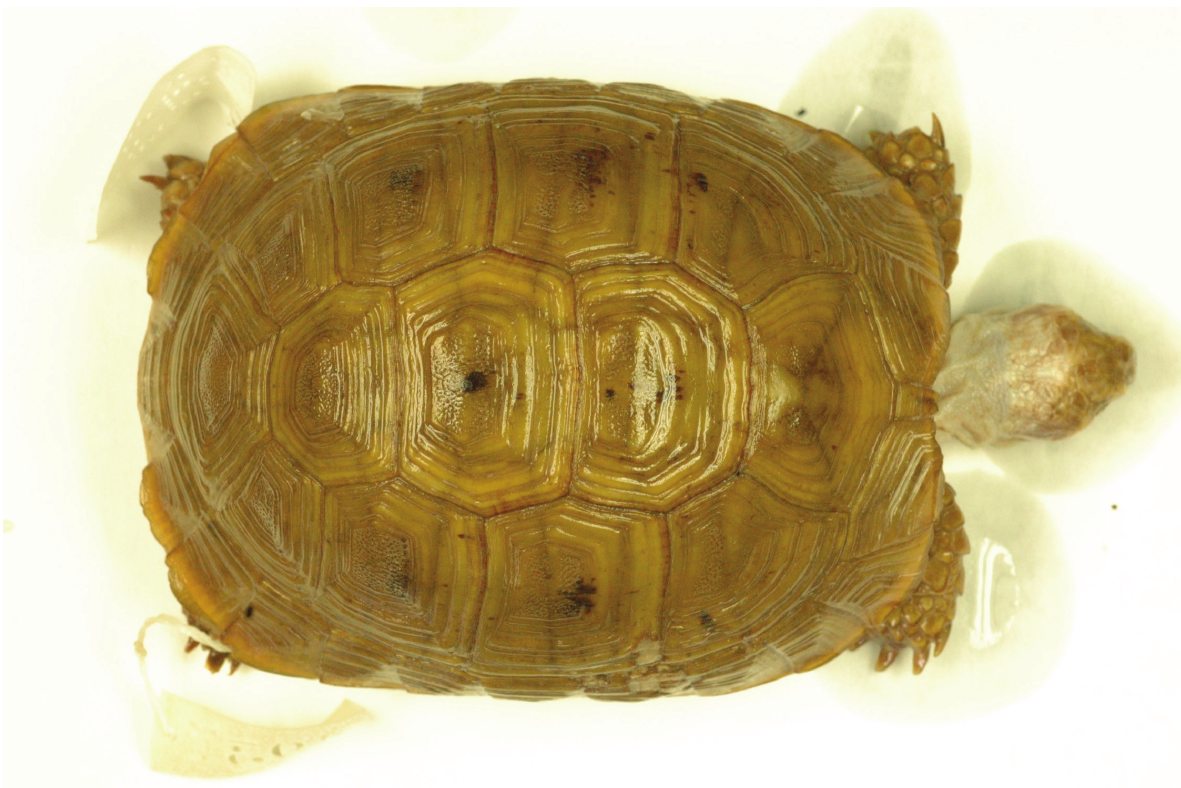
Figure 2. MNHN 0.1937., designated Neotypus of Testudo graeca mauritanica , dorsal. (Photograph: A. Ohler).